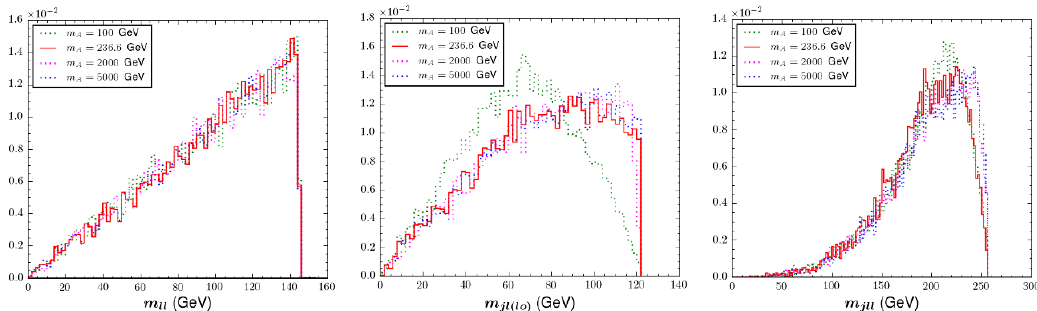
Figure 6 . Unit-normalized invariant mass distributions for the four study points from table 1: the distribution of m ‘‘ (left panel), m (middle panel), and m j‘‘ (right panel). The lines are color j‘ (lo) coded according to our conventions from (cid:12)gure 2 and table 1: red for P 31 , blue for P 41 , magenta for P 43 and green for P 23